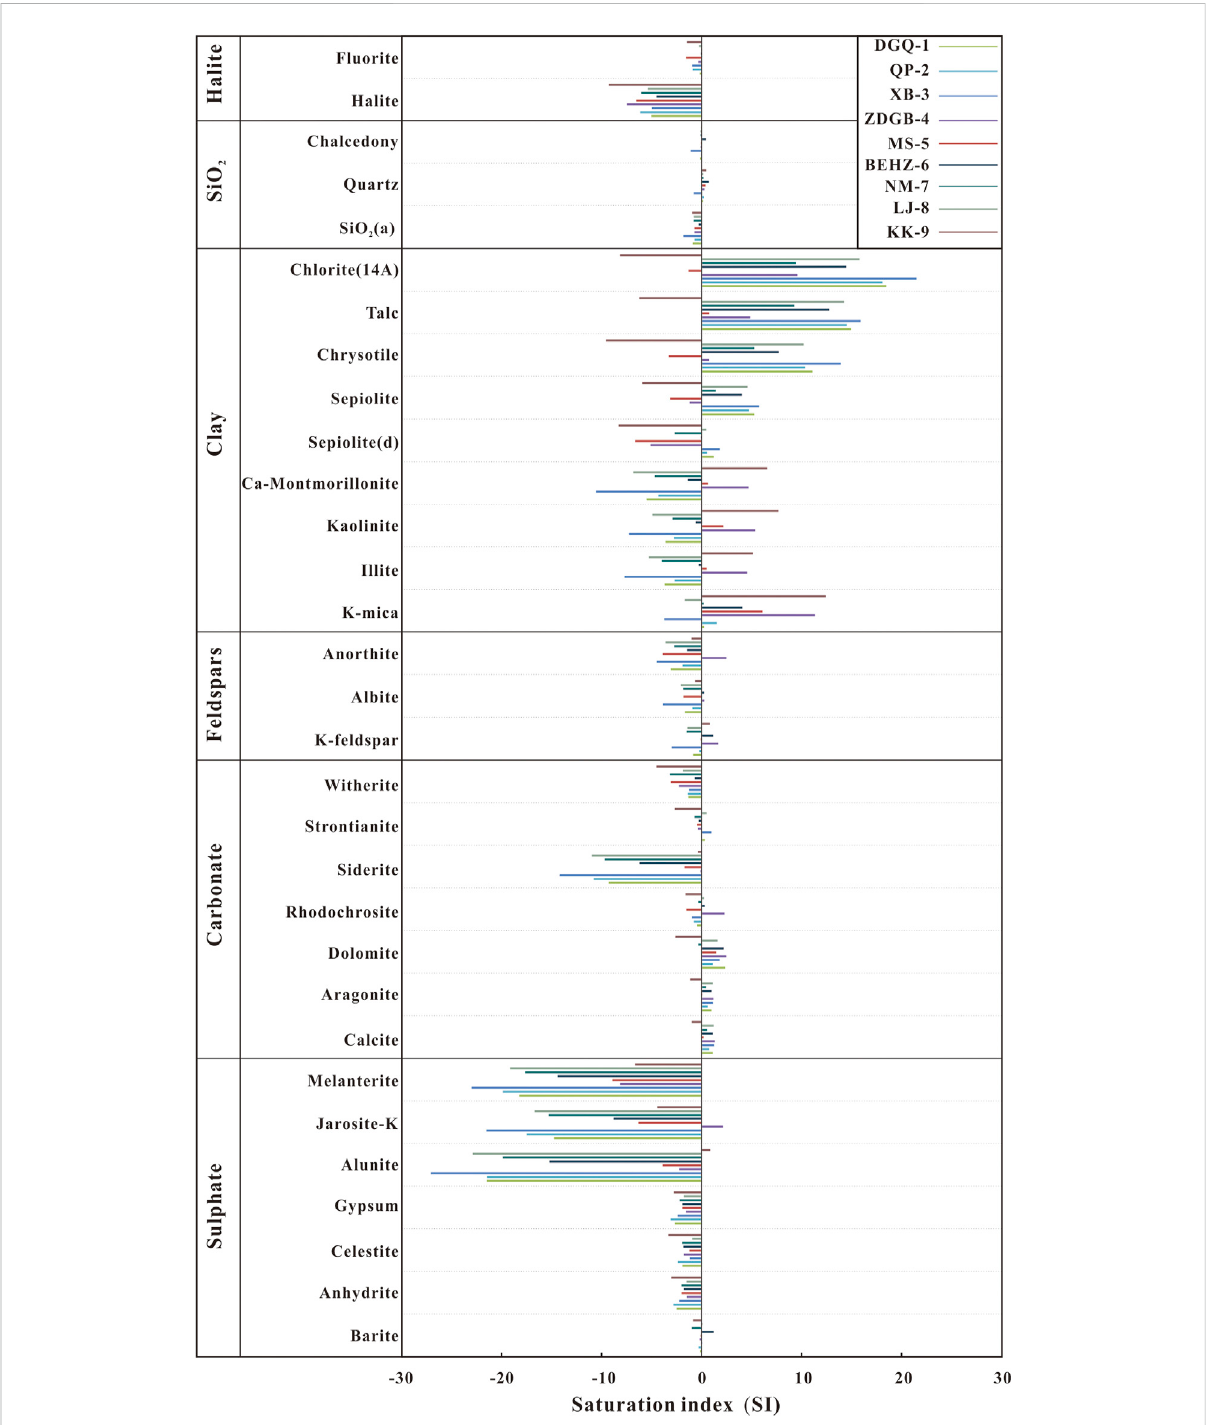
FIGURE 7 Saturation indexes of geothermal springs along the KKF zone at the out fl ow temperature.